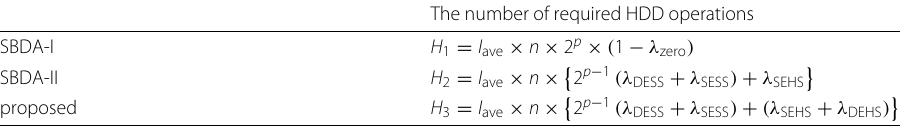
Table 2 The usage number of HDD in each syndrome-based decoding algorithm The number of required HDD